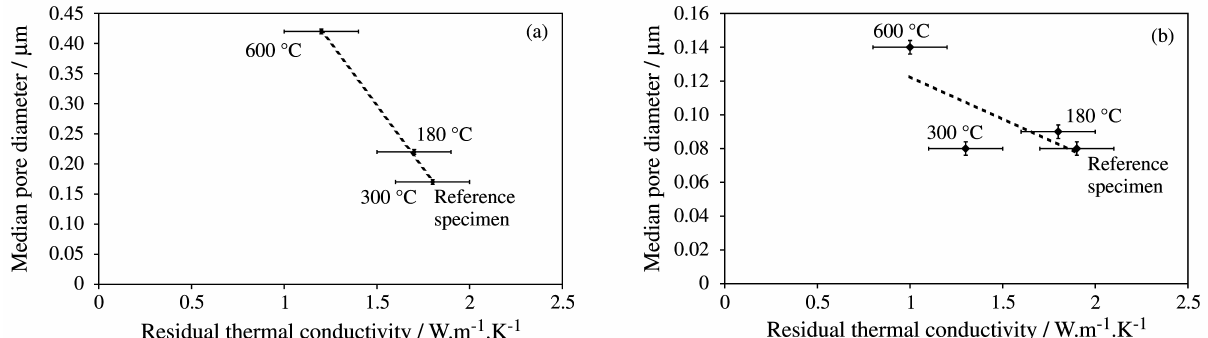
Figure 7. Residual thermal conductivity vs. median pore diameter curve obtained from mercury intrusion porosimetry tests: (a) f ck of 20 MPa; (b) f ck of 50